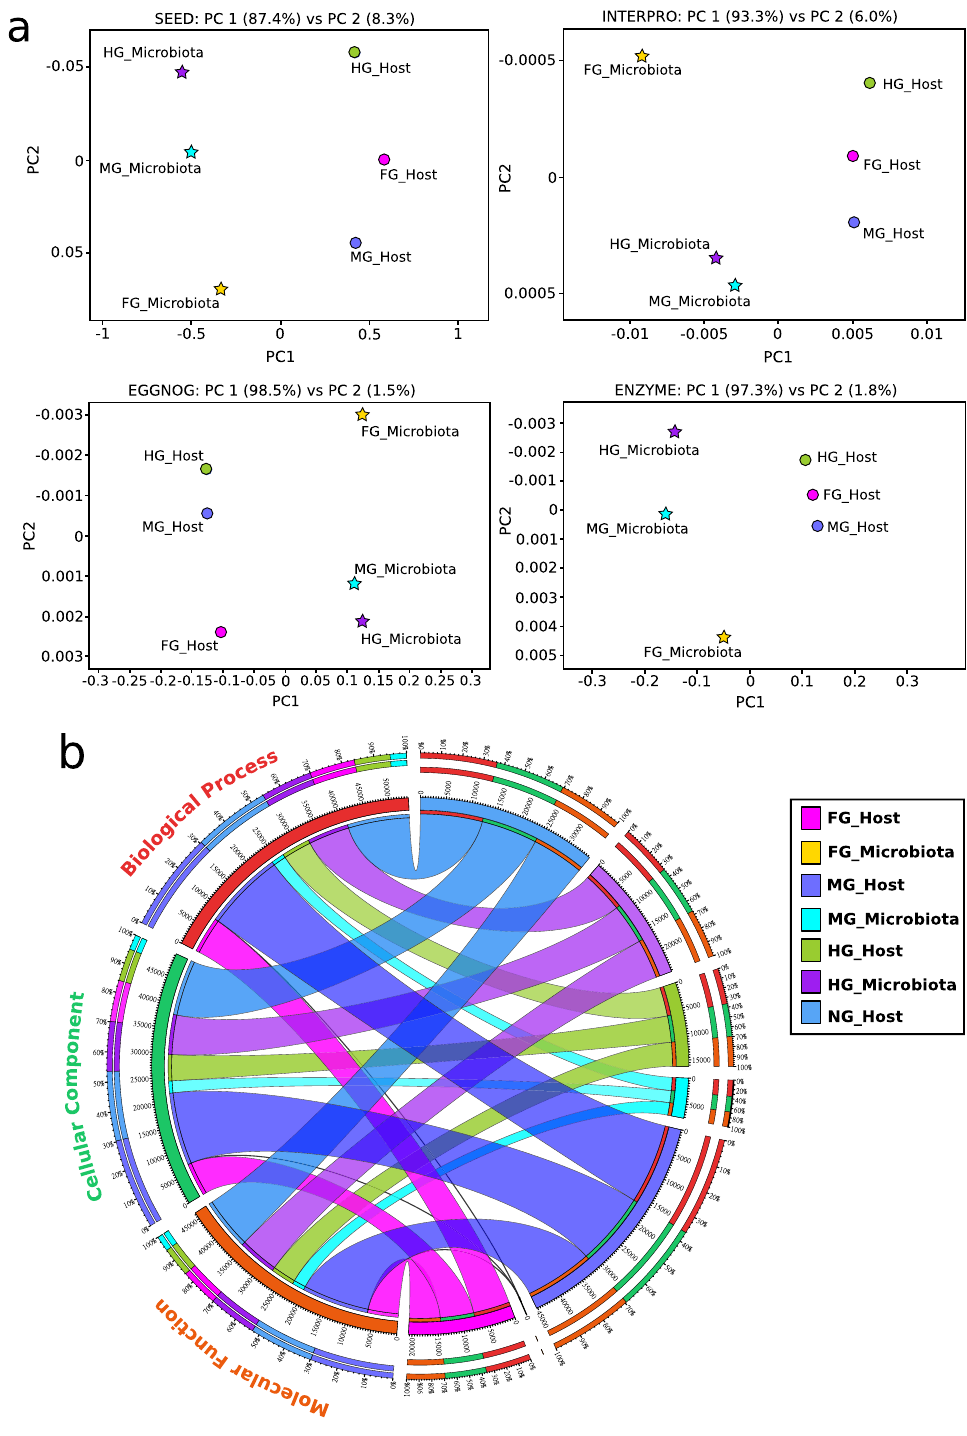
Figure 3. The functional genes in the millipede holobiont retained their taxonomic identity, and their contribution to the overall biological functions is different. ( a ) Principle coordinate analysis of functional genes from host and microbiota in the foregut (FG), midgut (MG), and hindgut (HG) using four functional databases, i.e. SEED, InterPro, eggNOG, and ENZYME. Genes belonging to host and microbiota are shown with circles and stars, respectively. ( b ) Circos plot representation of the distribution of genes belonging to the three most widely defined gene ontology (GO) categories (i.e. Biological Process, Cellular Component, and Molecular Function). GOs were plotted for the host as well as microbiota present in the foregut (FG), midgut (MG), hindgut (HG). Non-gut (NG) segment depicted GO expression in the millipede host